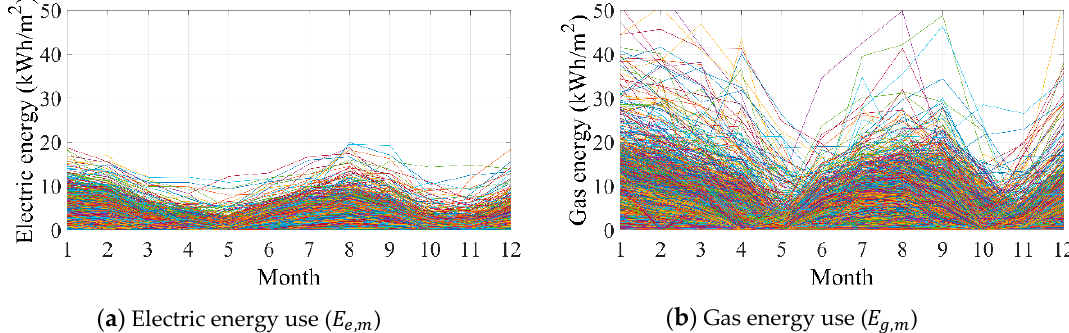
Figure 6. Monthly ( a ) electric energy use ( E e,m ) and ( b ) gas energy use ( E g,m ) for buildings with electric chillers as the dominant cooling system (3098 out of 4625 buildings).